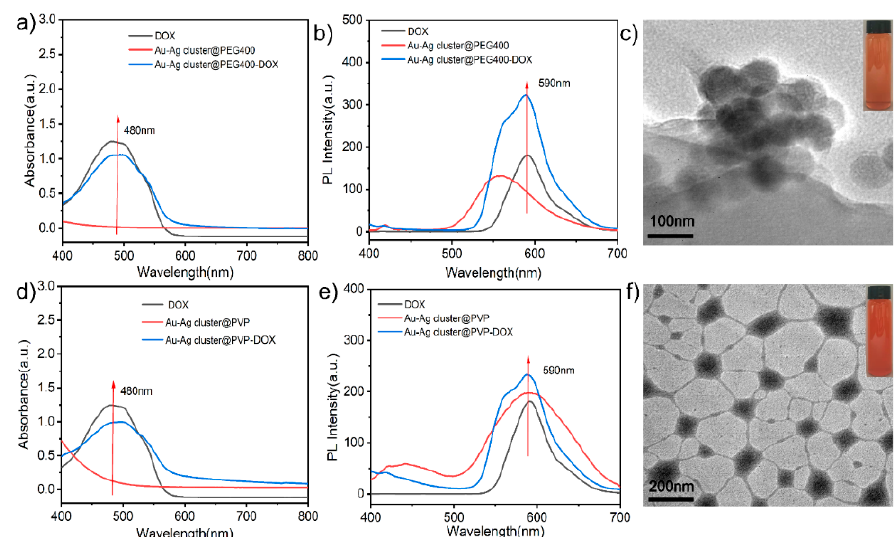
Figure 4. ( a ) UV–vis absorption and ( b ) PL spectra of DOX, Au-Ag cluster@PEG400 and Au-Ag cluster@PEG400-DOX, respectively; ( c )TEM images of Au-Ag cluster@PEG400-DOX; ( d ) UV–vis absorption and ( e ) PL spectra of DOX, Au-Ag cluster @PVP and Au-Ag cluster @PVP-DOX, respectively; ( f ) TEM images of Au-Ag cluster@PEG400-DOX.